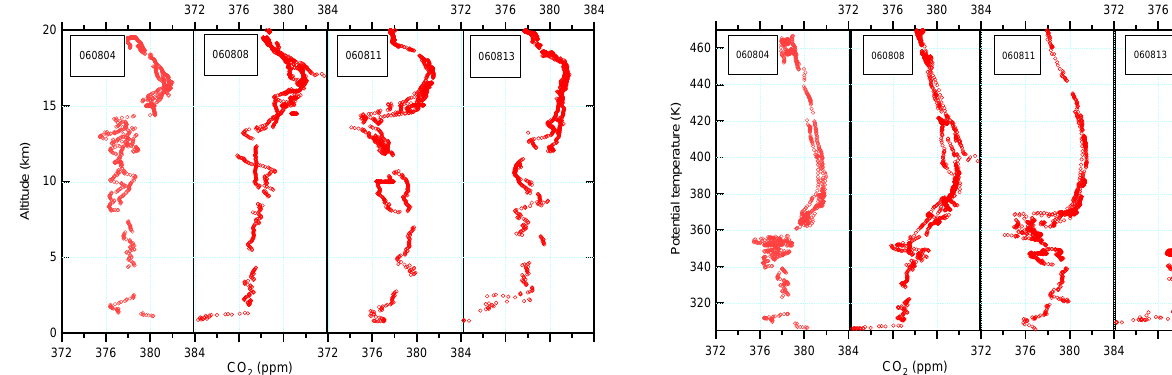
Fig. 1. Vertical profiles of CO 2 for the local flights on 4, 8, 11 and 13 August, respectively.